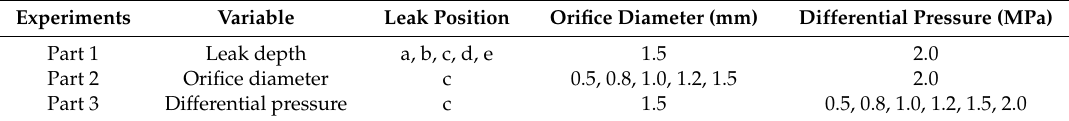
Table 1. Experimental design.